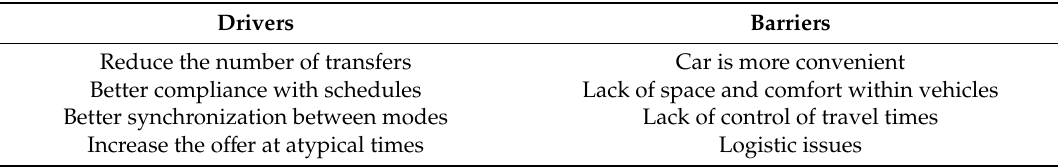
Table 1. Drivers and barriers to public transport